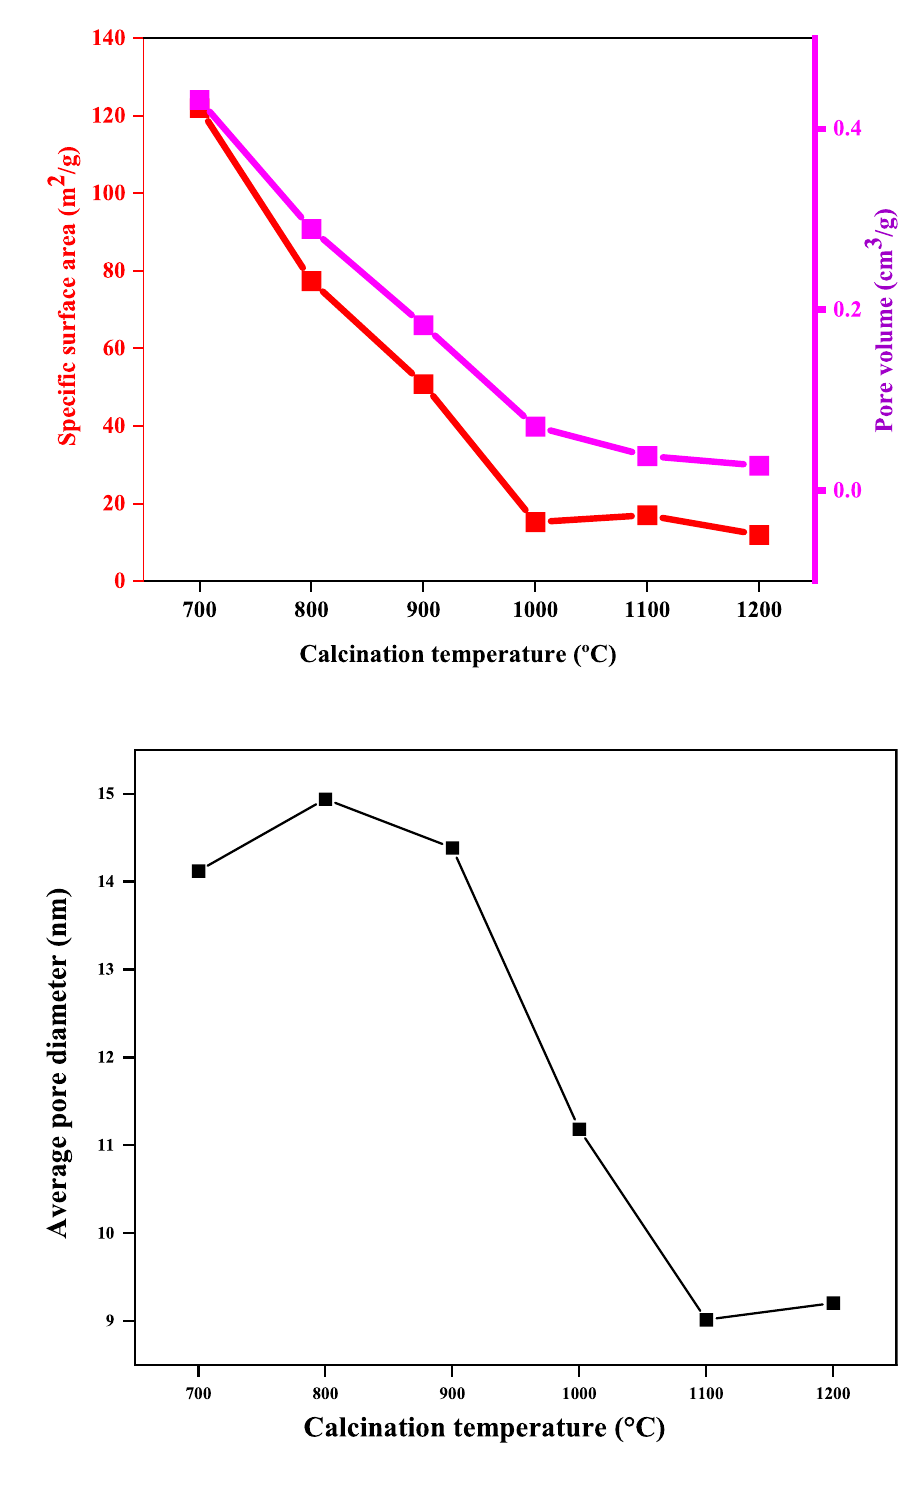
Fig. 9 Effect of calcination temperatures upon pore char- acteristics of BeO nanofibers